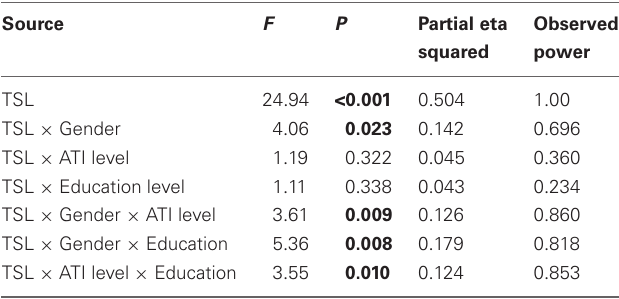
Table 2 | Tests of within- and between-subjects’ effects on number of JABS. Source F P Partial eta Observed